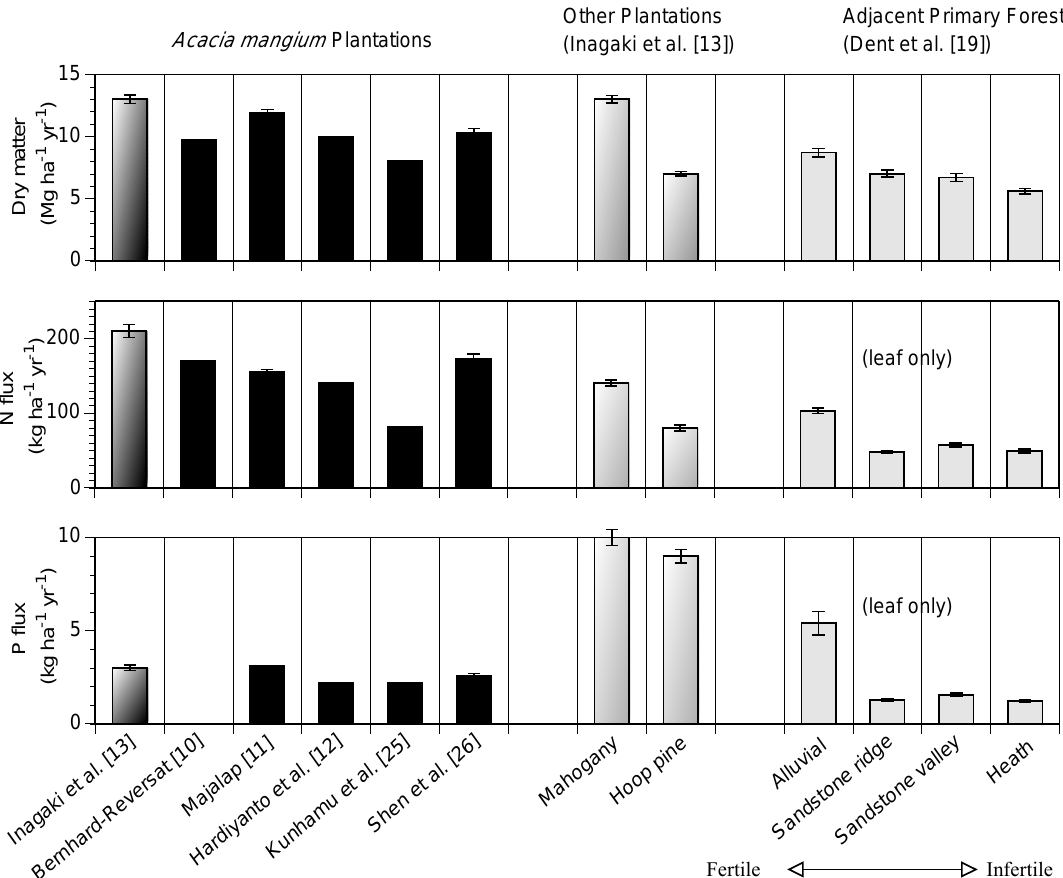
Figure 1. Litterfall mass, and N and P flux via litterfall in A. mangium plantations, Mahogany ( S. macrophylla ) and Hoop pine ( Ar. cunninghamii ) plantations, and